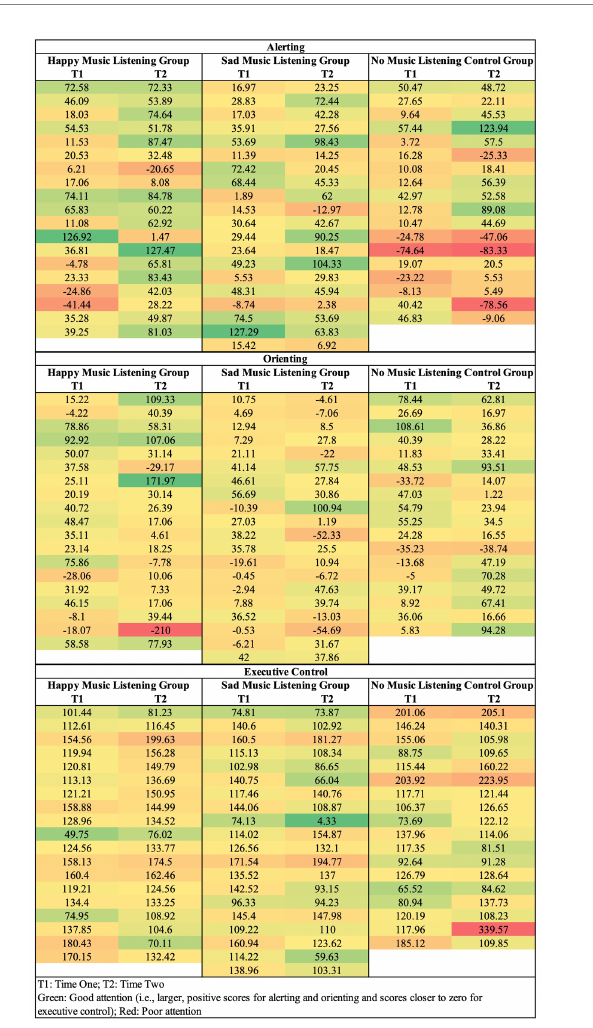
FIGURE 4 Individual variation in how alerting (reaction time difference score for no cue–double cue), orienting (reaction time difference score for center cue–valid spatial cue), and executive control (reaction time difference score for incongruent–neutral trials) change from time one to time two for each participant. Green shading represents better attention and red shading poorer attention. The individual data depicts a similar pattern as the whole-group analysis: alerting attention predominately changes in response to happy music and executive control in response to sad